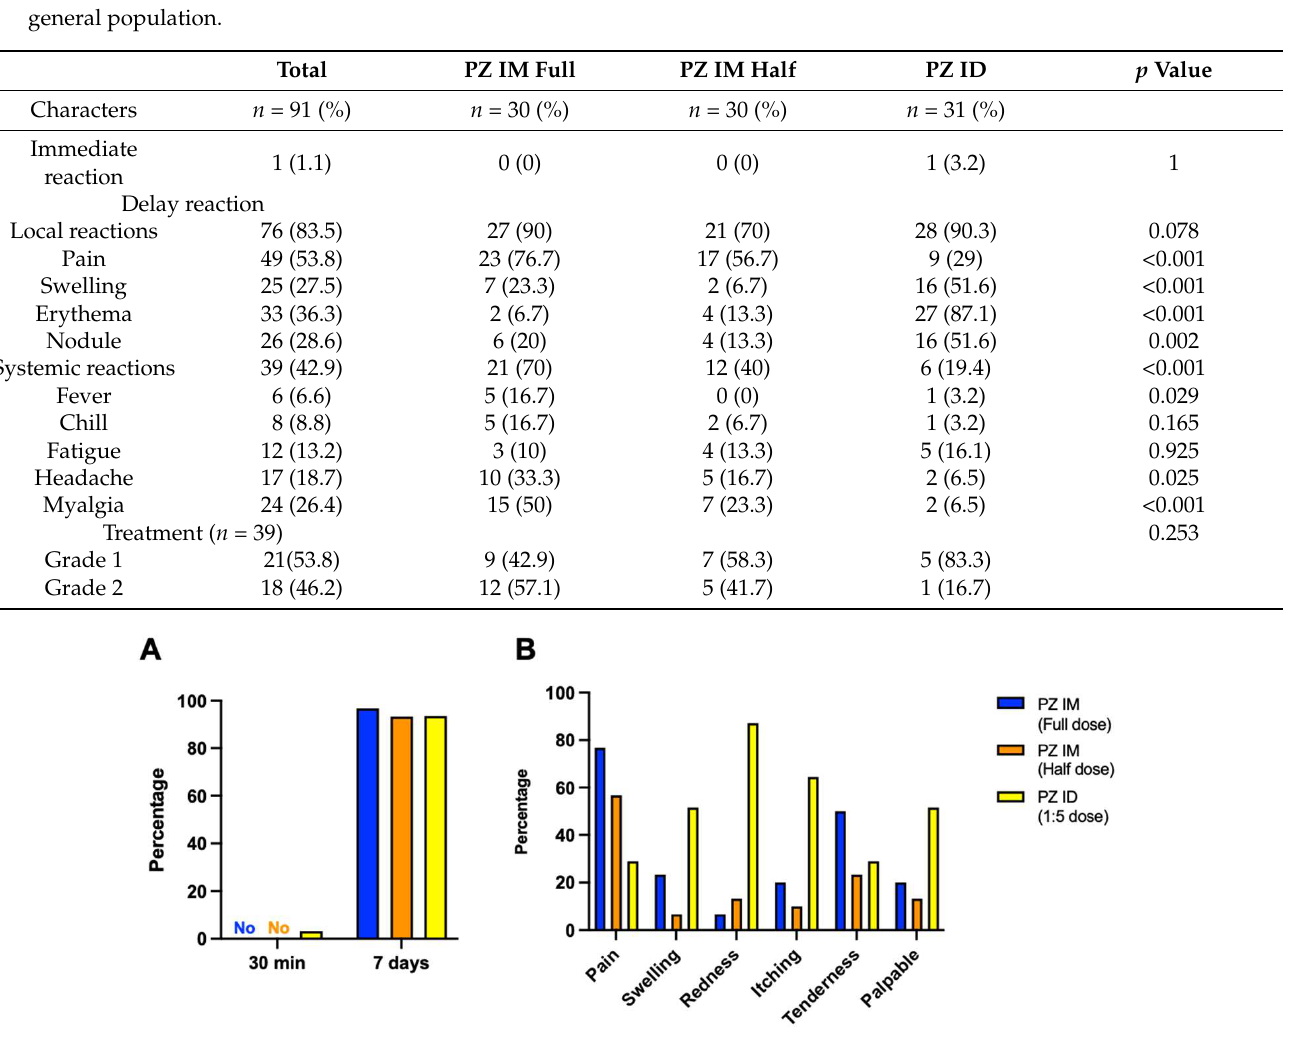
Figure 2. Solicited local adverse reactions at 30 min and 7 days after boosting. Full dose (blue) and half dose (orange) of intramuscular mRNA booster, after completed vaccination with two doses of inactivated SARS-CoV-2. Some of the previously vaccinated individuals were boosted with a fractional dose of intradermal mRNA vaccine (yellow). ( A ) The immediate and delayed local reactions were observed after injection. ( B ) Seven days after boosting, local adverse events were recorded for comparing between booster